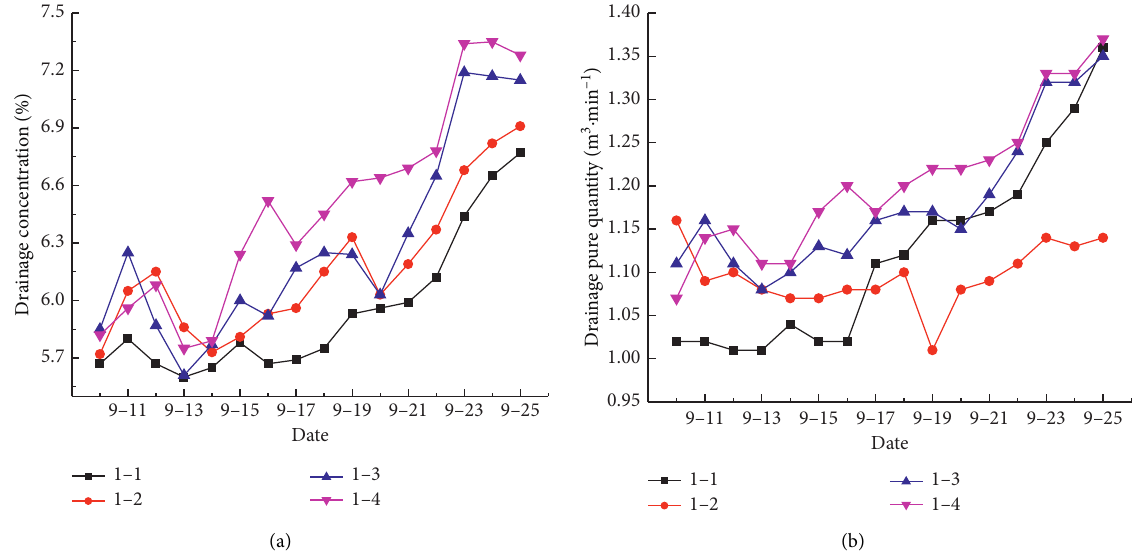
Figure 13: Extraction effect of #1 high directional long borehole. (a) Drainage concentration. (b) Drainage pure